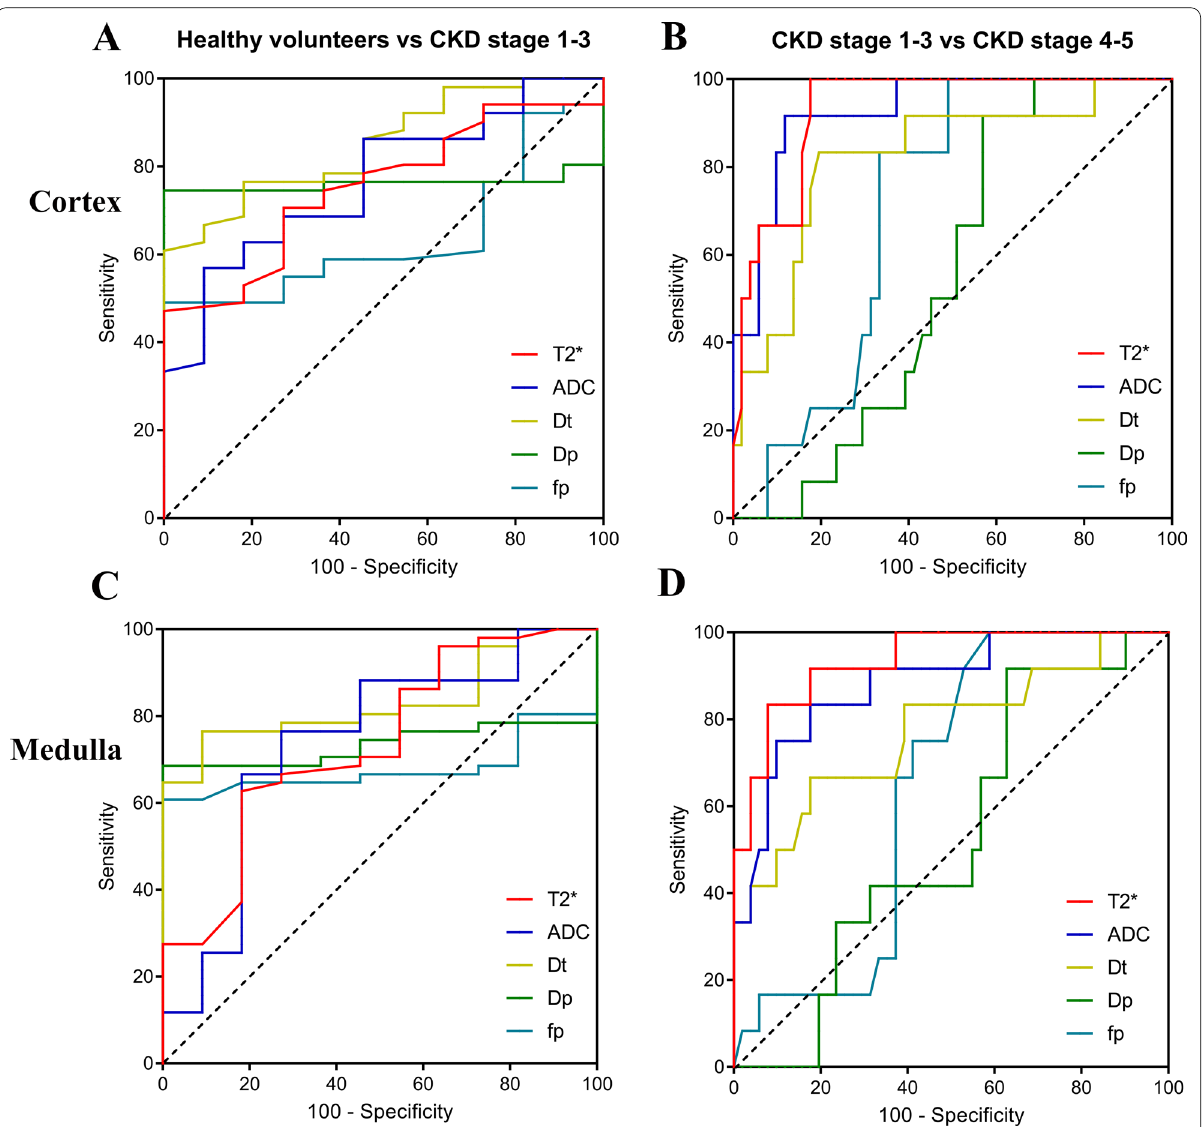
Fig. 7 ROC curves for the diagnostic performance of MRI- derived parameters (T2*, ADC, D t , D p , and f p ) for differentiating CKD stage 1–3 from helthy volunteers or CKD stage